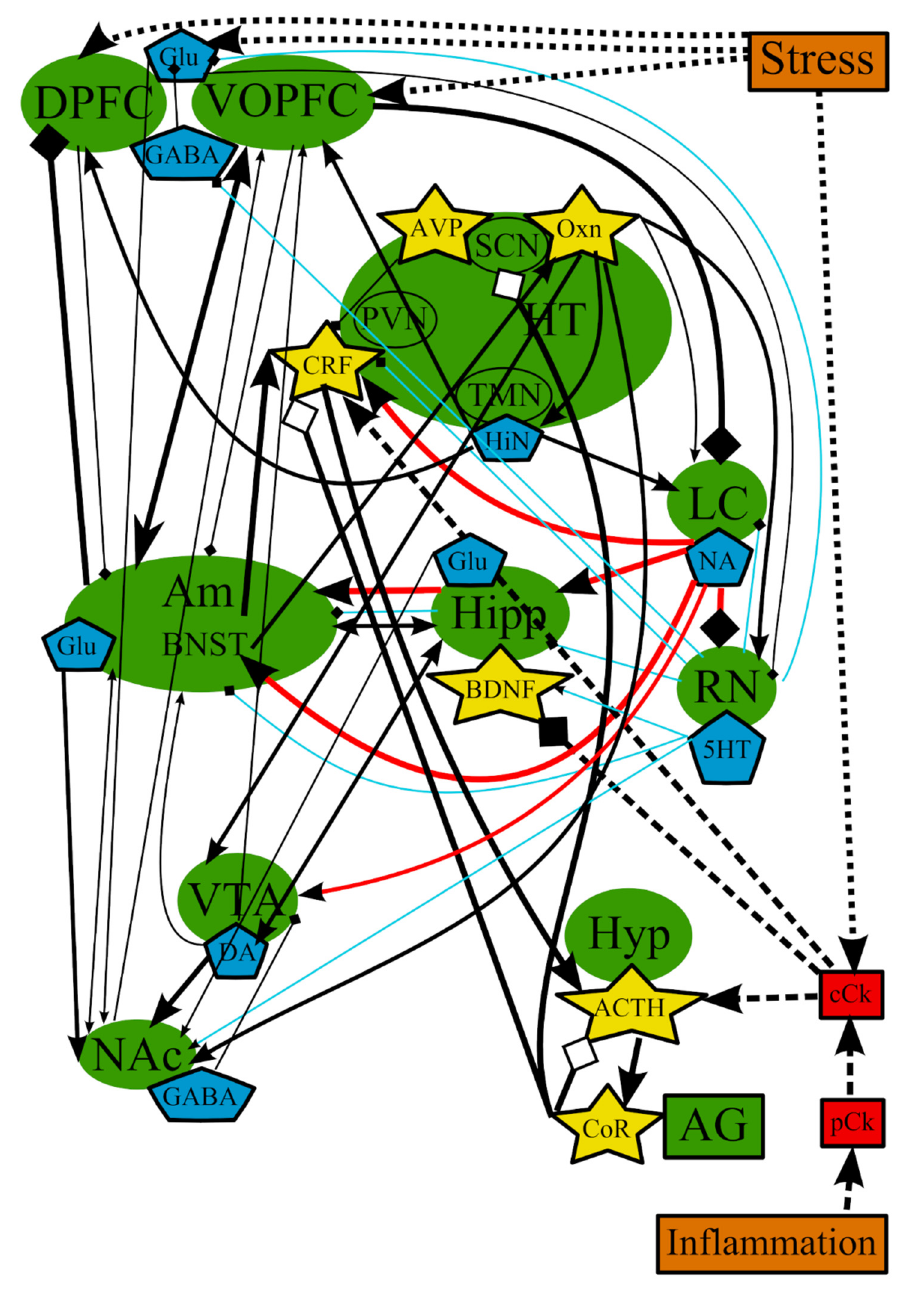
Figure 6. The overall picture of the combined common mechanisms and relationships of all major theories of depression. ACTH—adrenocorticotropic hormone; AG—adrenal gland; Am—amygdala; AVP—arginine-vasopressin; BDNF—brain-derived neurotrophic factor; BNST—bed nuclei stria terminalis; cCk—central pro-inflammatory cytokines; CoR—cortisol; CRF—corticotropin- releasing factor; DA—dopamine; DPFC—dorsal prefrontal cortex; Glu—glutamine; GABA—gamma-aminobutyric acid; HiN—histamine; Hipp—hippocampus; HT—hypothalamus; 5-HT—serotonin; Hyp—hypophysis; LC—locus ceruleus; NA—noradrenaline; NAc—nucleus accumbens; Oxn—orexin; SCN—suprachiasmatic nucleus; TMN—tuberomammilar nucleus; RN—raphe nucleus; pCk—peripheral pro-inflammatory cytokines; PVN—paraventricular nucleus; VOPFC— ventral and orbital prefrontal cortex; VTA—ventral tegmental area; -> (arrow): activating effect; - <> (rhombus): a black rhombus—inhibitory effect; a white rhombus—an effect is blocked or inef- fective because the receptor is not sensitive; thick line—effect is increased; thin line—effect is de- creased; medium thickness line—the effect is not changed or alterations of the effect are unknown; red line—noradrenaline effect; blue line—serotonin effect; black line—various neurotransmitters or neuropeptides; dotted lines—influence of external factors.